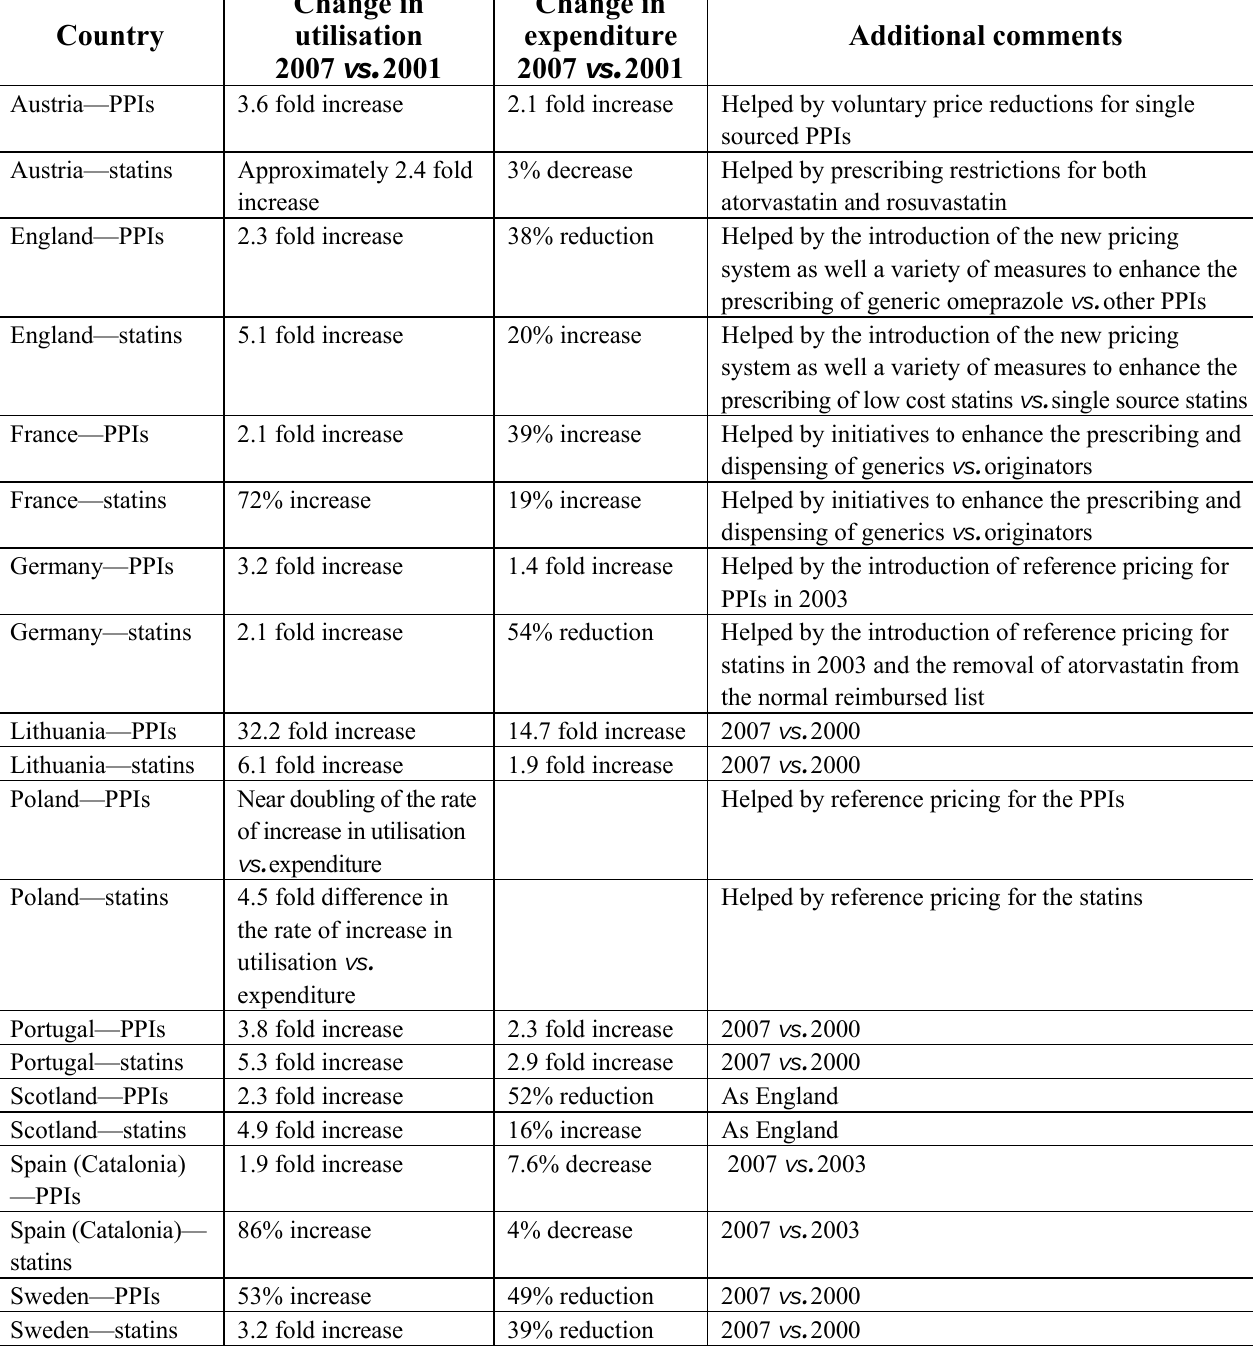
Table 2. Impact of the various measures on the utilisation and expenditure of PPIs and statins in exemplar countries in 2007 vs. 2001 unless